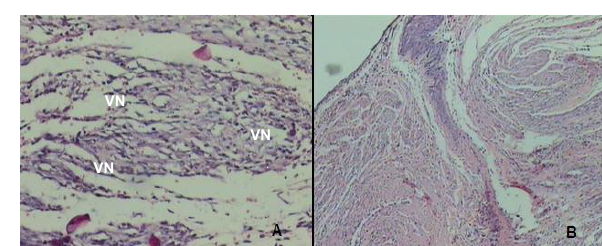
FIGURA 6 - Fibroblastos em feixes compactos são obser - vados em animal do SGP7 (A) e fibroblastos esparsos em animal do SGC7 (B).